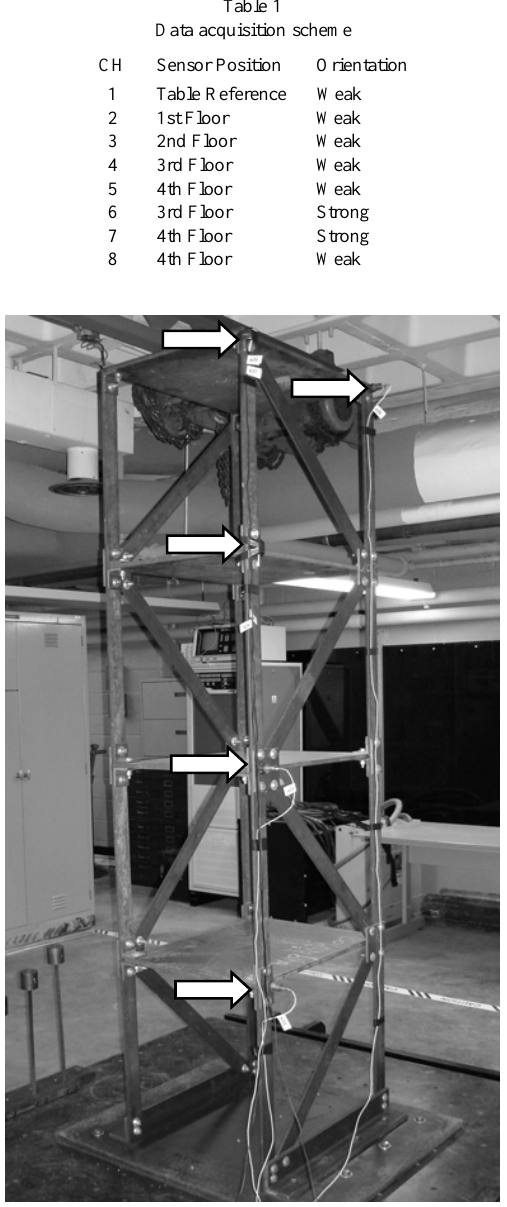
Fig. 1. Model with accelerometer positions shown by